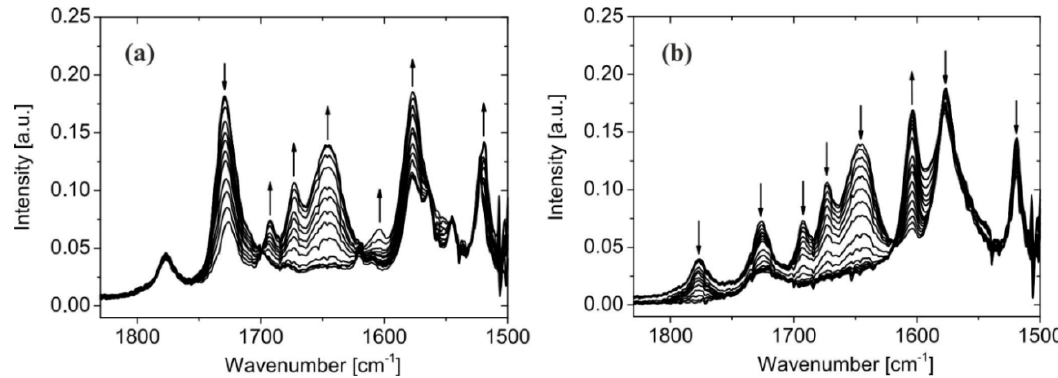
Figure 8. Spectroscopic changes in the IR during electrochemical reduction of complex 2 to 2 − ( a ) and of 2 − to 2 2− ( b ) in a 0.2 M NBu 4 PF 6 /THF solution at r. t.